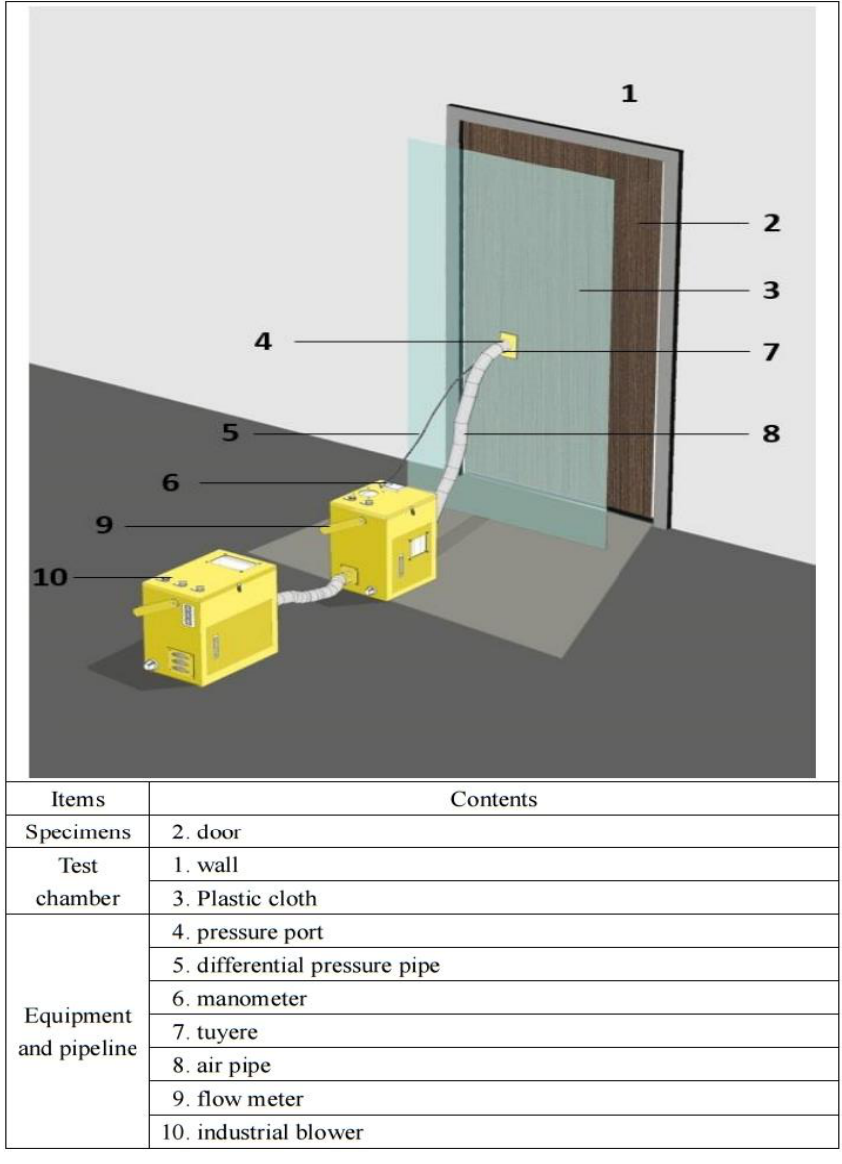
Figure 2. Schematic diagram of the configuration of the equipment for the field test.